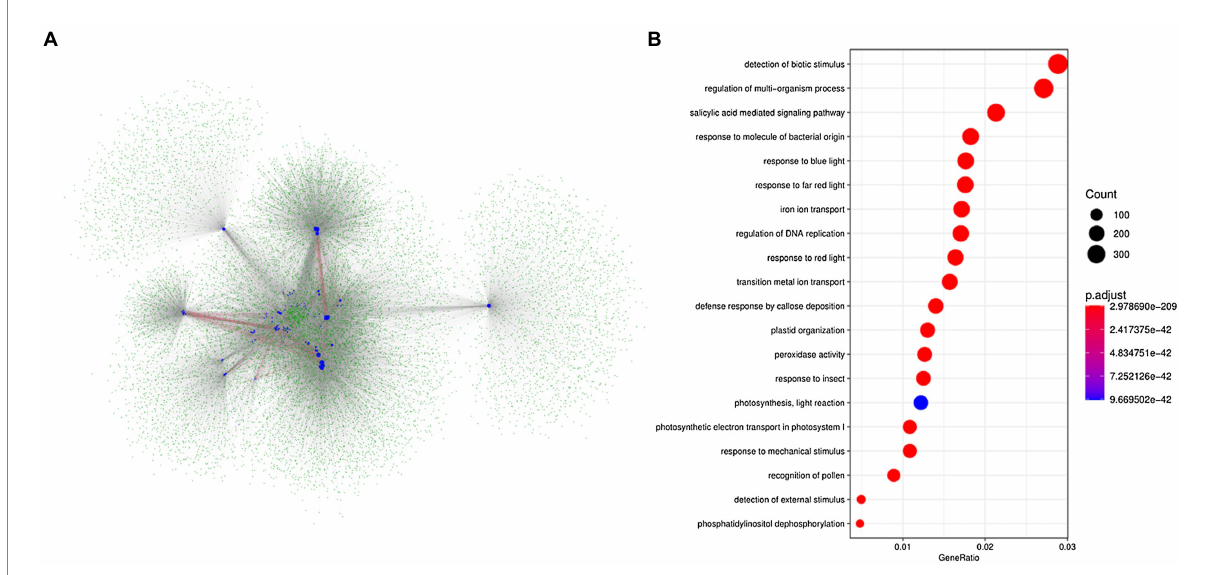
FIGURE 4 Analysis of the network for the interaction of BnLegLu proteins in B. napus . (A) Protein–protein interaction network of BnLegLu. The BnLegLu proteins are indicated by medium blue circles, and the green circles represent the proteins that interact with BnLegLu proteins. The red lines indicate the interaction between BnLegLu proteins, and the gray lines represent the interaction between BnLegLus and other proteins. (B) GO analysis of proteins interacting with BnLegLu